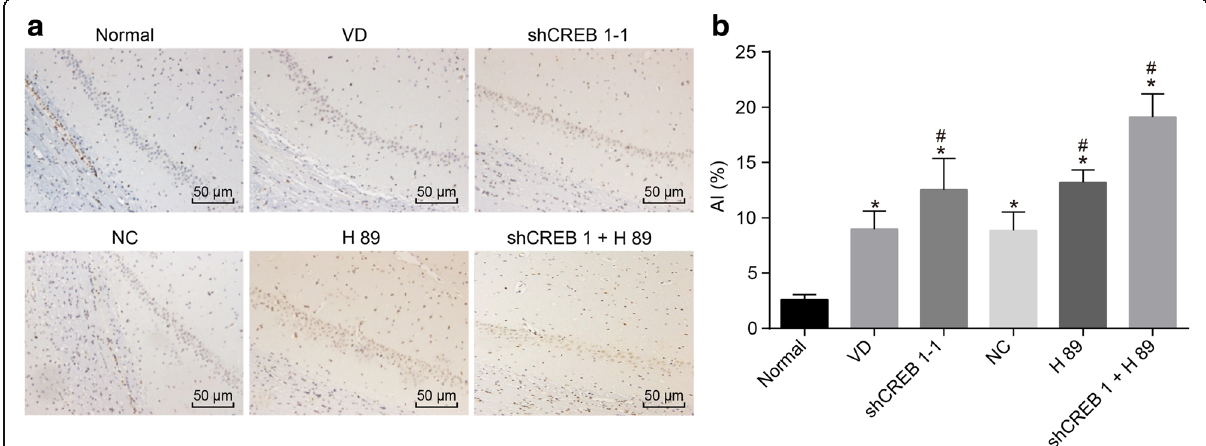
Fig. 6 Increased neuronal apoptosis in hippocampal CA1 area of mice injected with shCREB1 – 1 or/and H89, Notes: A, the TUNEL staining results of CA1 in hippocampus of mice in each group (× 200); B, the histogram of apoptotic index of hippocampal CA1 neurons of mice in each group; * , p < 0.05, compared with the normal group; # , p < 0.05, compared with the VD group; CREB1, cyclic adenosine monophosphate responsive element-binding protein 1; VD, vascular dementia